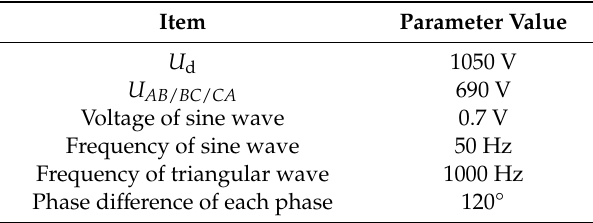
Table 6 is the parameters of main components of GSC. Table 6. Parameters of main components of GSC.